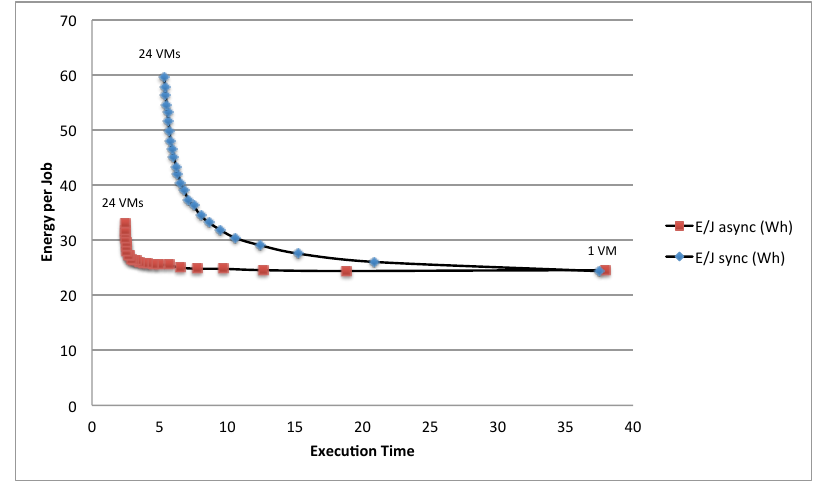
Figure 18. Bounds for energy per job and execution time varying the number of